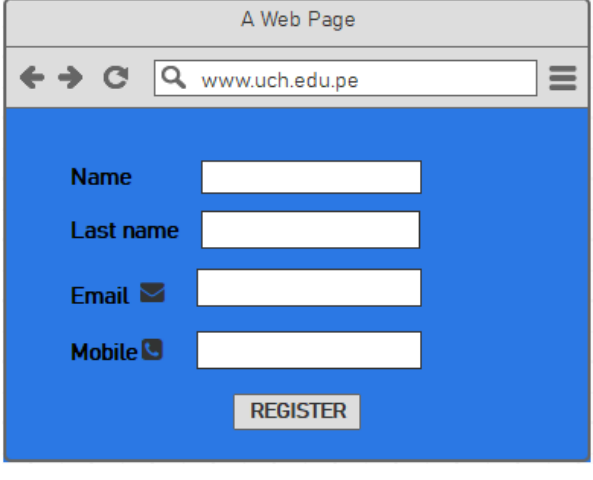
Fig. 7. User's registration